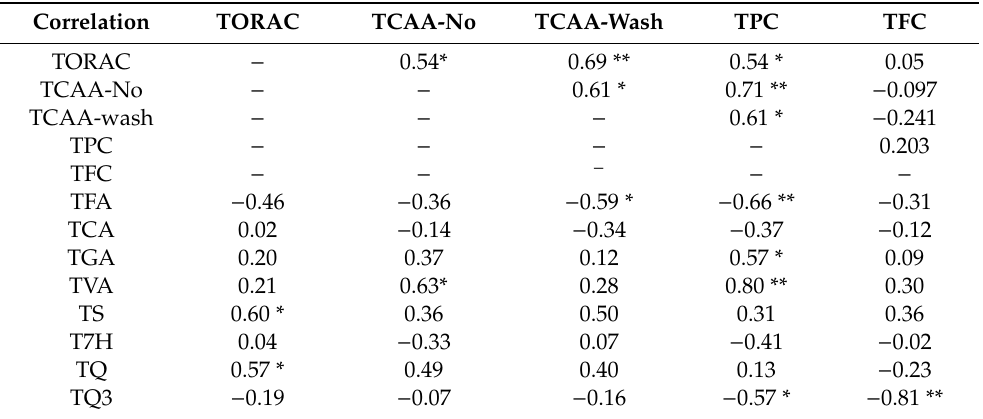
Table 3. Pearson correlation coe ffi cient among phenolics, flavonoids, phytochemical composition and antioxidant